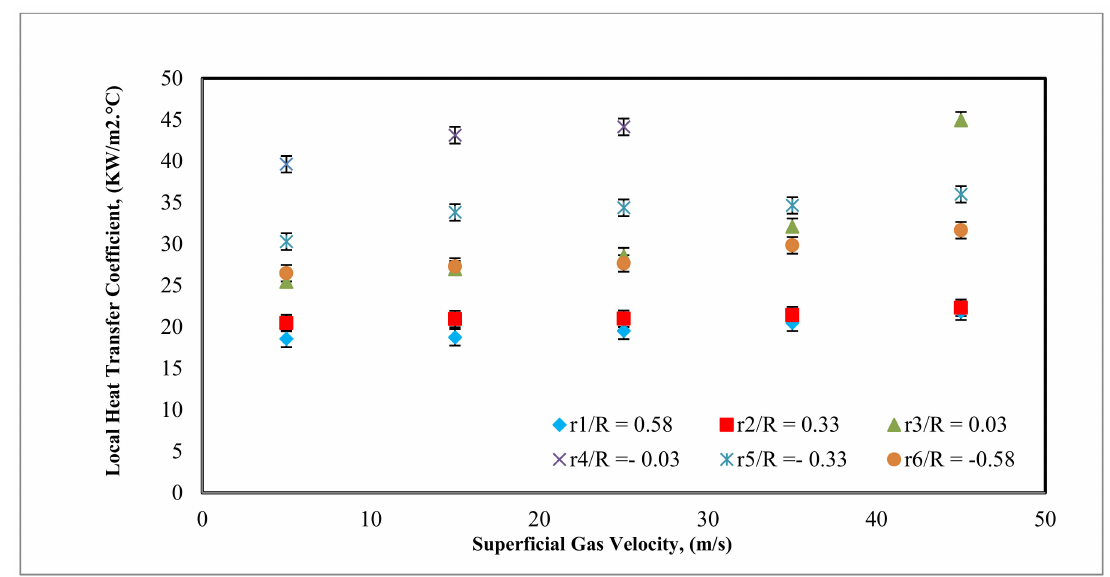
Figure 6. Impact of superficial gas velocity on local heat transfer coefficient at (H/D = 5) for triangular arrangement.